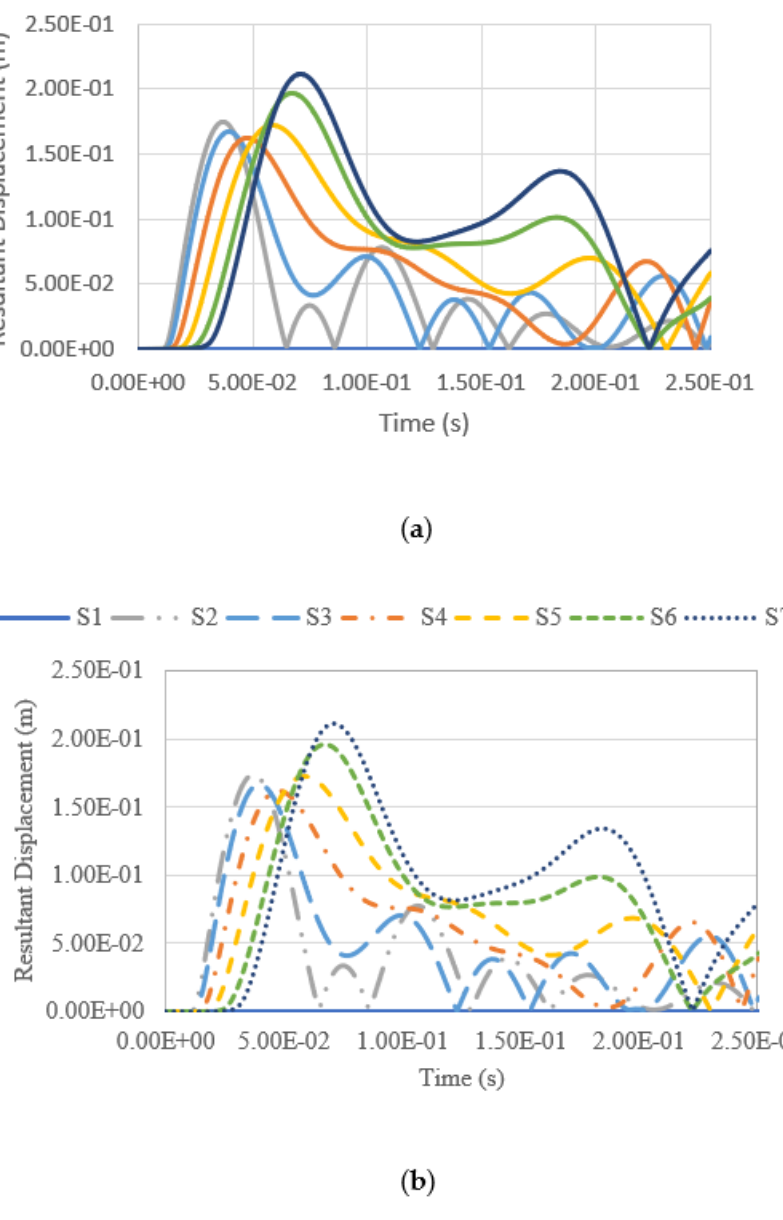
Figure 15. Resultant displacement versus time under blast intensity of 1500 kg TNT equivalent mass 25 m away, ( a ) 100% fill and ( b ) 0% fill.